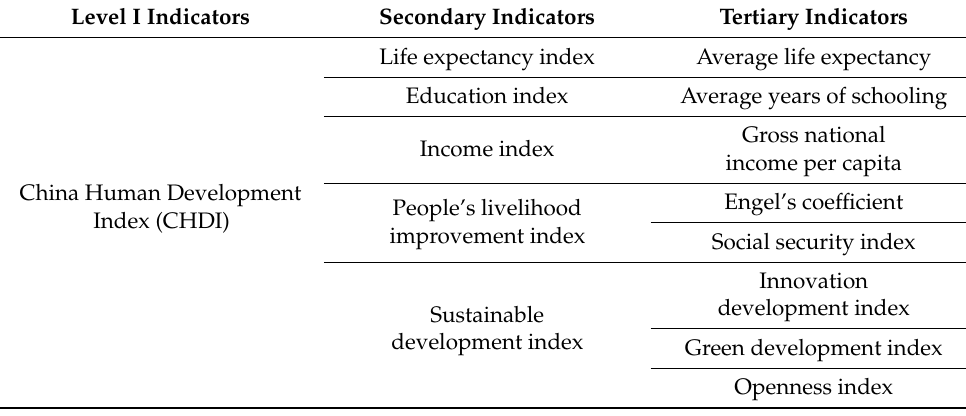
Table 1. China Human Development Index (CHDI) indicator